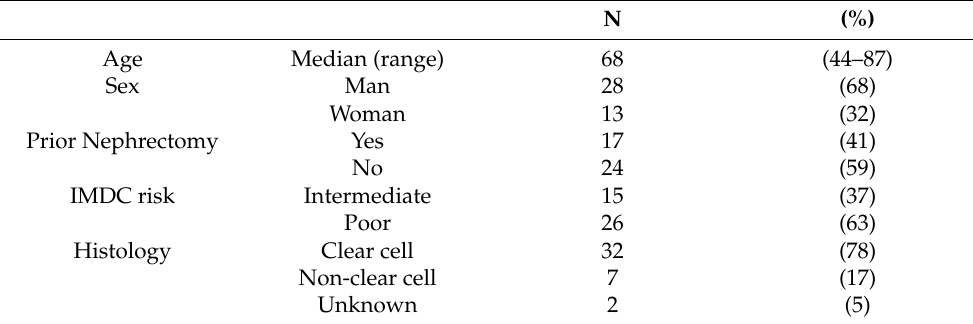
Table 1. Patients’